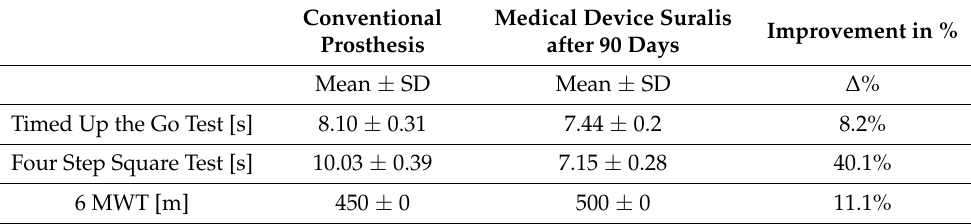
Table 4. Results for functional assessments (timed up and go, four square step and 6 min walk test) for patient 4 with conventional prosthesis and after 90 days with the medical device Suralis. Over all the tests, a significant functional improvement was